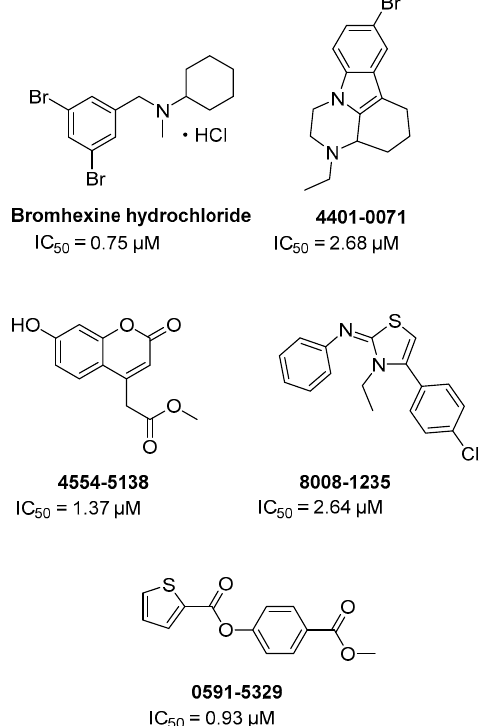
Figure 12. Chemical structures of Bromhexine hydrochloride and additional four hits identified by a biochemical HTS as TMPRSS2 inhibitors, with their inhibitory biochemical HTS as TMPRSS2 inhibitors, with their inhibitory activity.